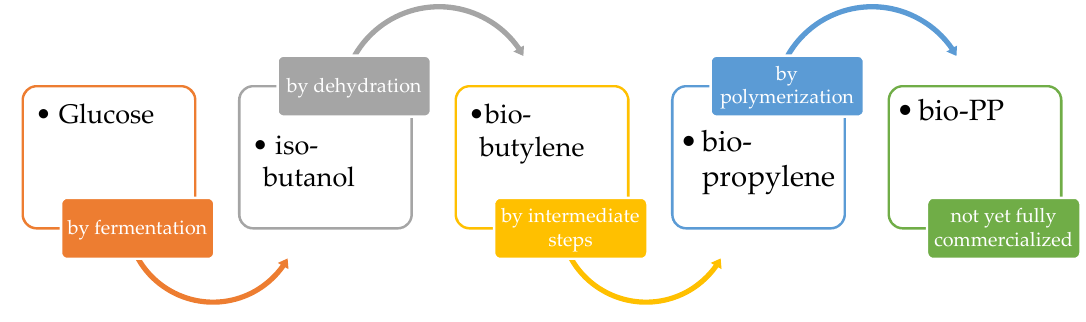
Figure 8. General scheme for